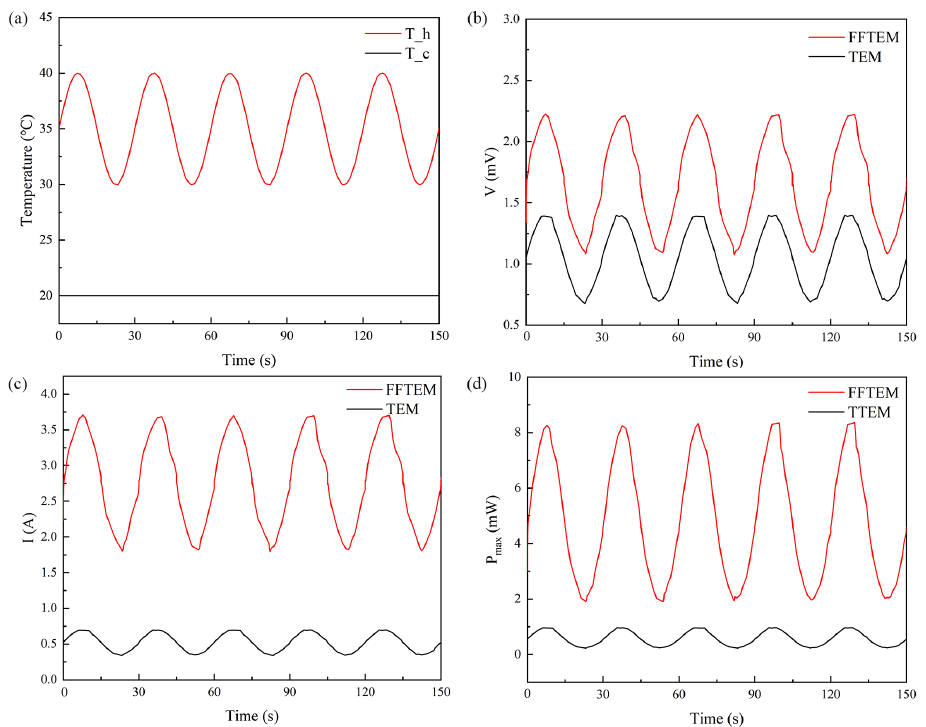
Figure 9. ( a ) Boundary temperature, ( b ) output voltage, ( c ) working current, and ( d ) maximum output power for the FFTEM and TTEM models as a function of time.